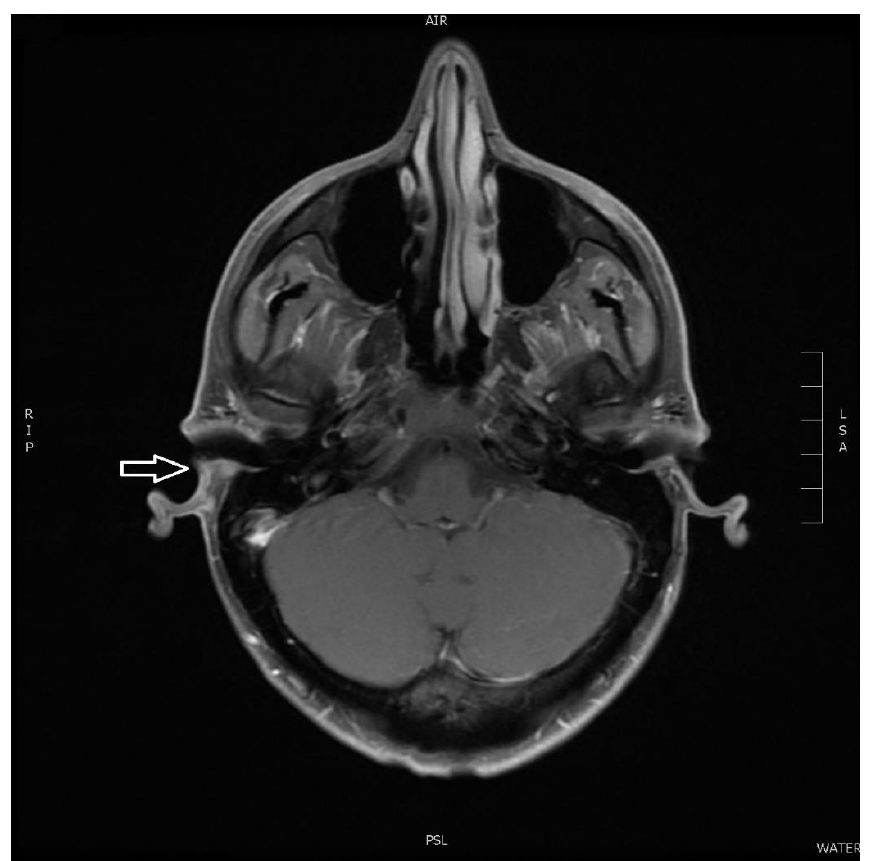
Figure 9. Follow-up MR performed 9 months after tumor removal. Axial postcontrast T1-weighted sequence showing sparse scar tissue in the posterior wall of the right external auditory meatus (arrow) and no signs of tumor recurrence.